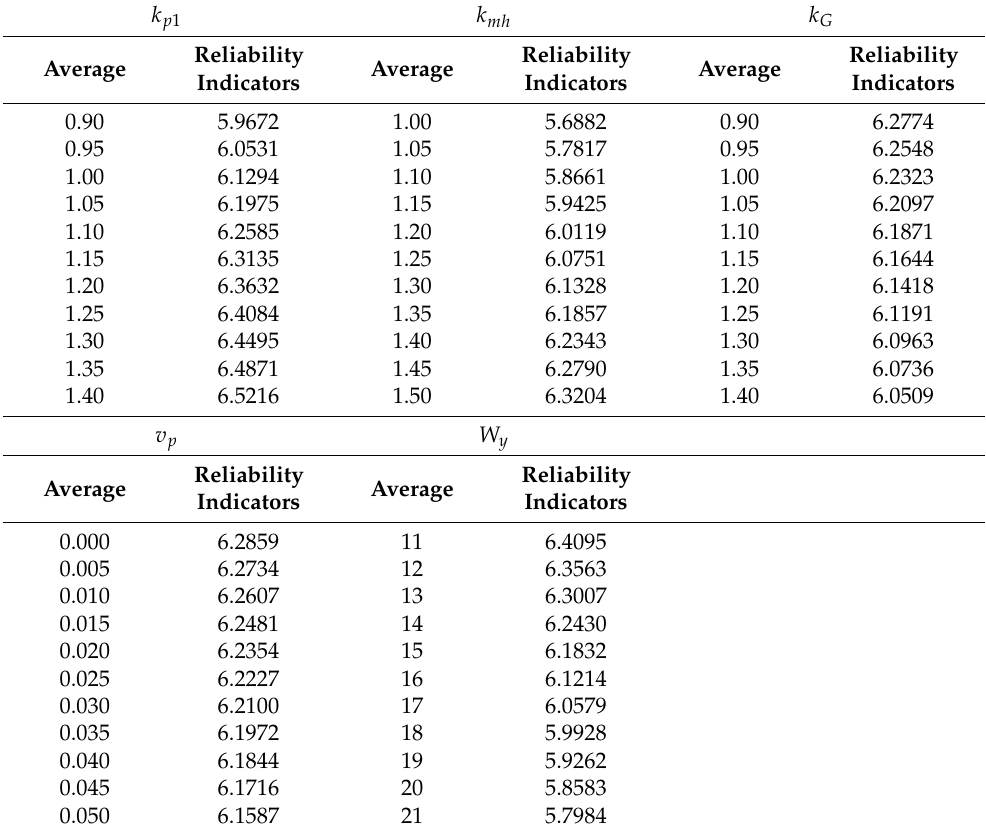
Table 7. Effect of the mean value of each parameter on the strength reliability index under combination II.